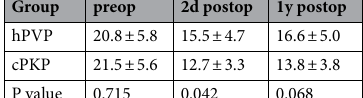
Table 5. The change of Cobb’s angle in the pre- and post-operative period.